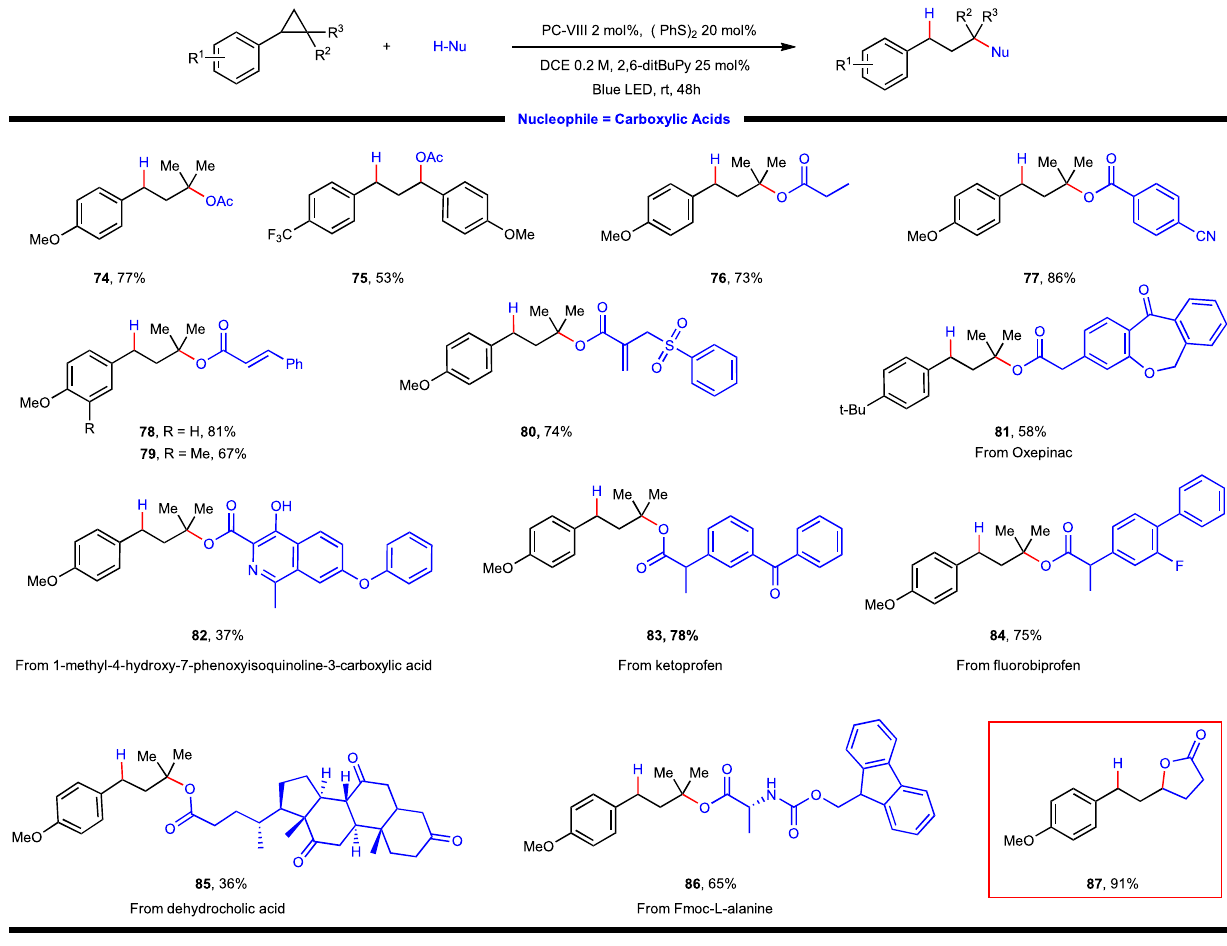
(0.04mmol, 0.2 equiv.), 2,6-ditBu-Py (0.05mmol, 0.25 equiv.) and DCE (1.0mL, 0.2M) at 25°C for 48h under irradiation of a 15W blue LED